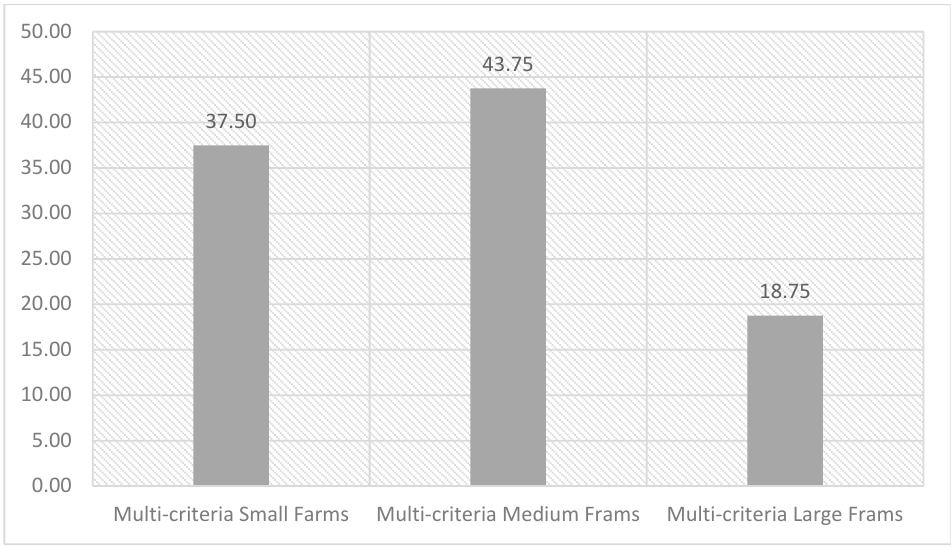
Figure 3. Distribution of farms across European countries (percentage); Source: own calculations .